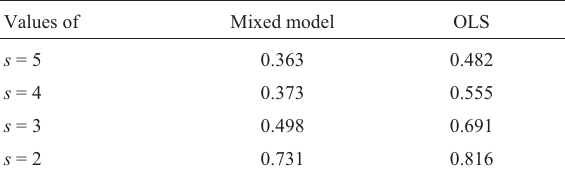
Table 4 - Bias of the correlation coefficient for different sizes of s under two statistical analysis models (ordinary least square - OLS and mixed